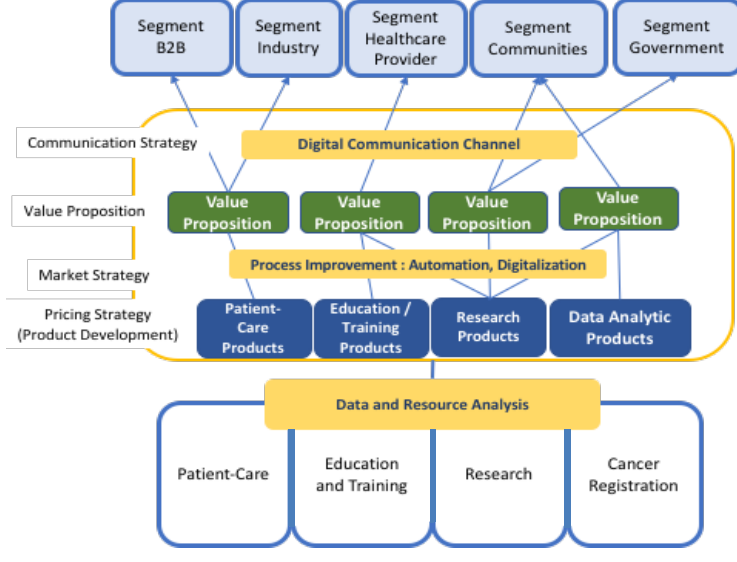
Figure 8. Sales and Marketing Activities Layer